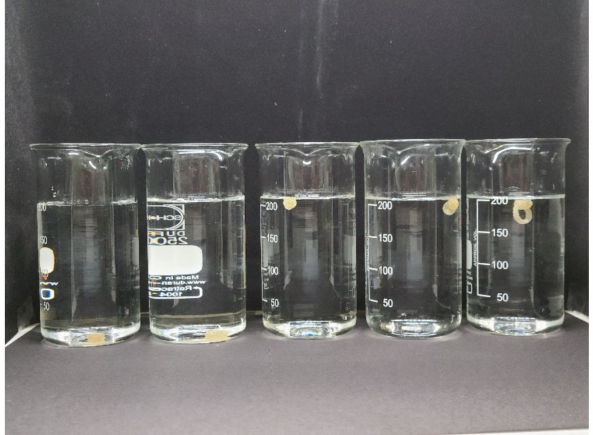
Figure 7. Floating comparison of cylinder, D12, float, cylinder–float (CF) and ring–float (RF)solid dosage forms from left.